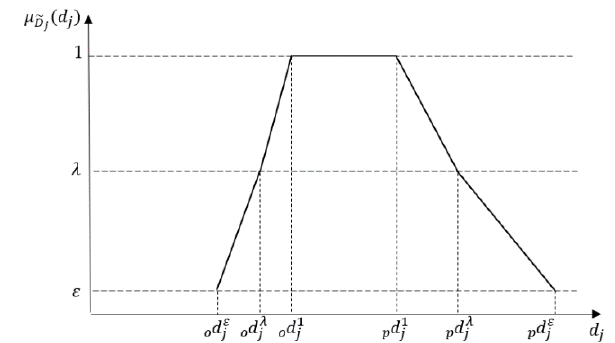
Figure 1. Illustrative example of a membership function based on six-point representation for a fuzzy disassembling duration D j of process j (adapted from [26]).